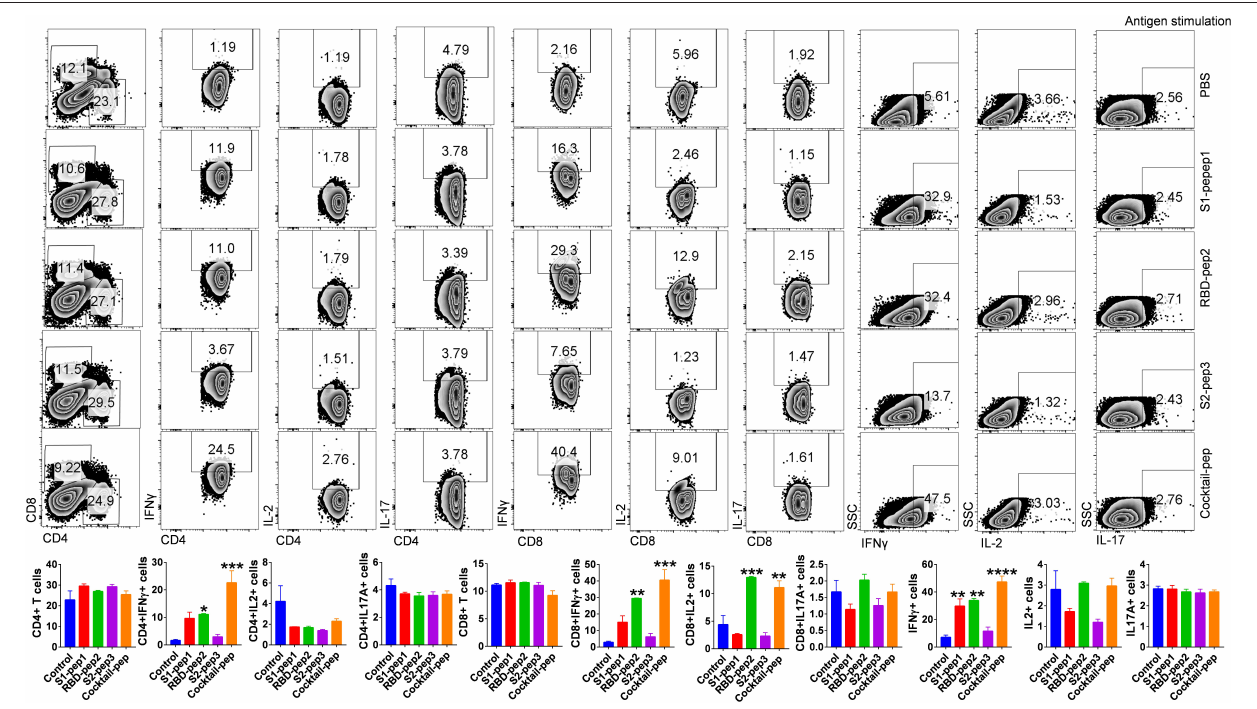
FIGURE 3 | Characterization of T-cell immune responses against SARS-CoV-2 antigens in mice. T-cell immune response against SARS-CoV-2 peptide antigens was studied in the spleen of immunized mice at 42 days post-immunization (p.i.). In vitro antigen-stimulated splenocytes were then used for intracellular cytokine staining for IFN γ , IL2, and IL17 cytokines after CD4 and CD8 surface staining. Stained cells were then acquired on BD FACSCanto II (BD Biosciences, CA, USA) and analyzed on FlowJo software (Tree Star, Inc., OR, USA). The top panel shows representative dot plots indicating mean percent positive values for various T-cell populations in the stimulated spleen. Bar graph plotted for percent positive ± standard errors of the mean (SEMs) for each group are shown (Bottom), where* p < 0.05, ** p < 0.01, *** p < 0.001, and **** p < 0.0001 (one-way